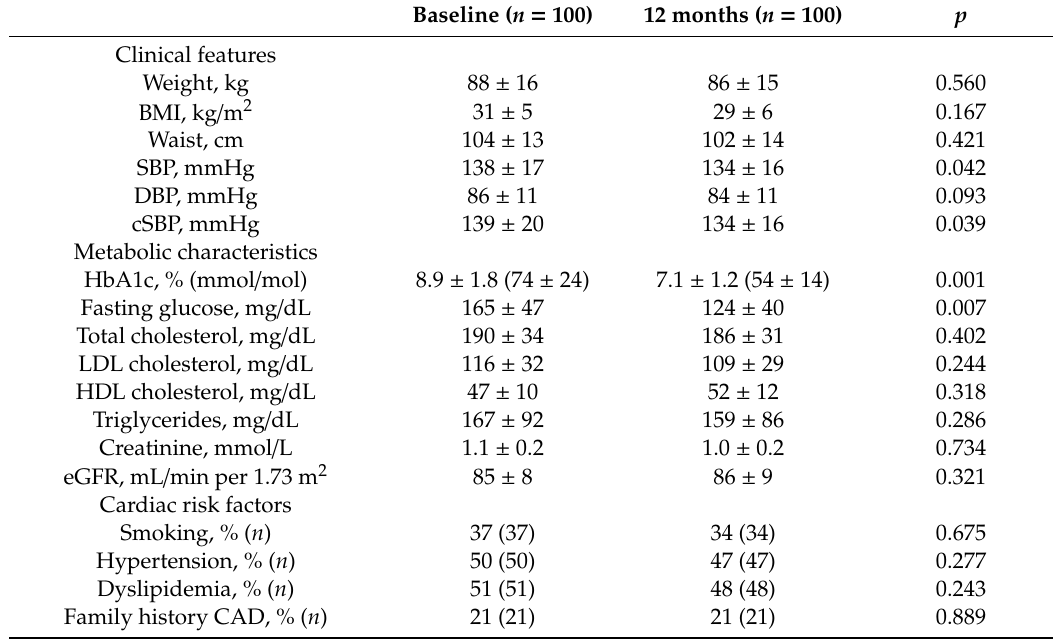
Table 1. Clinical and metabolic characteristics of